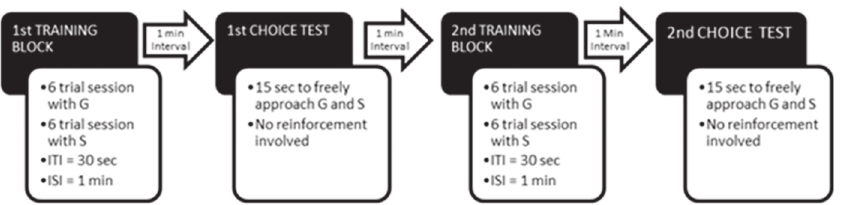
Fig 2. Experimental procedure in studies 1 and 2 (study 3 only involved the first training block and the first choice test). Note: G: generous experimenter; S: selfish experimenter; ITI: inter-trial interval; ISI: inter- session